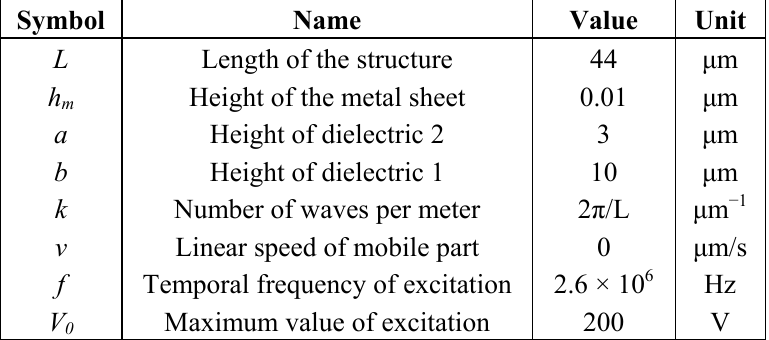
Table 2. Physical and geometrical parameters of the